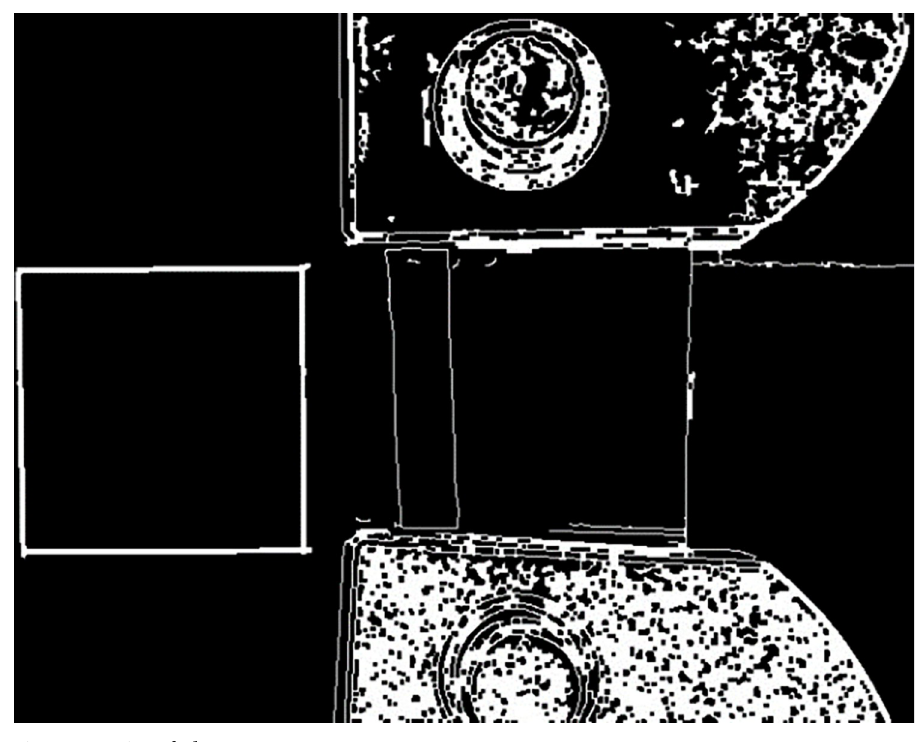
Fig 7. Extraction of